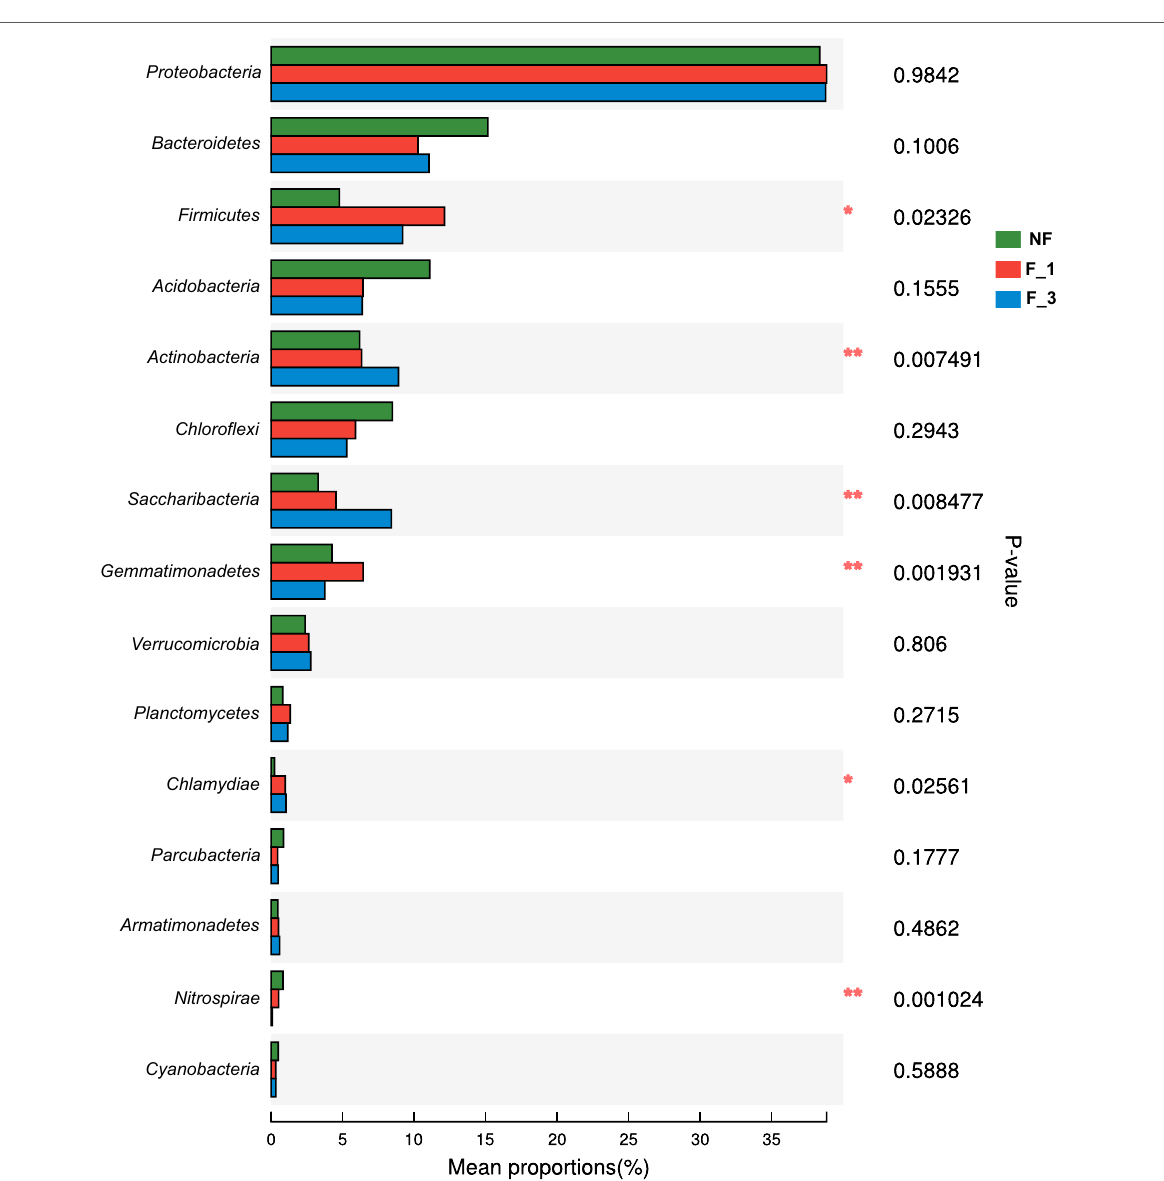
3). Stars indicate significant enrichment = 0.05, one star; 0.001 < P 0.01, two stars; ≤ ≤